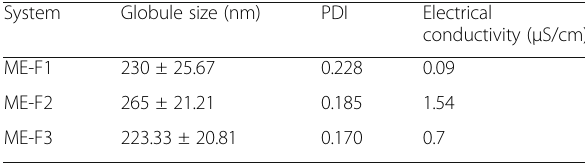
Table 4 Characterization parameters of prepared ME